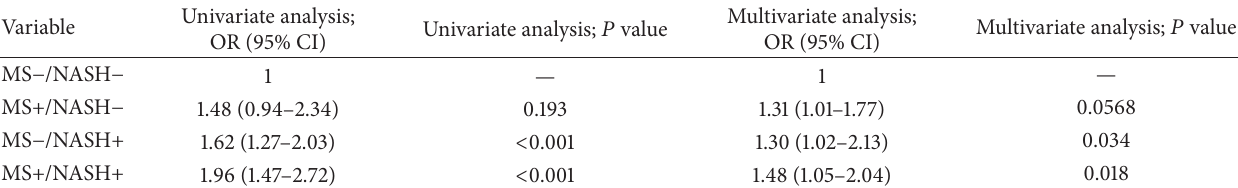
Table 3: Univariate and multivariate analysis of the risk for hyperplastic polyps by NASH and metabolic